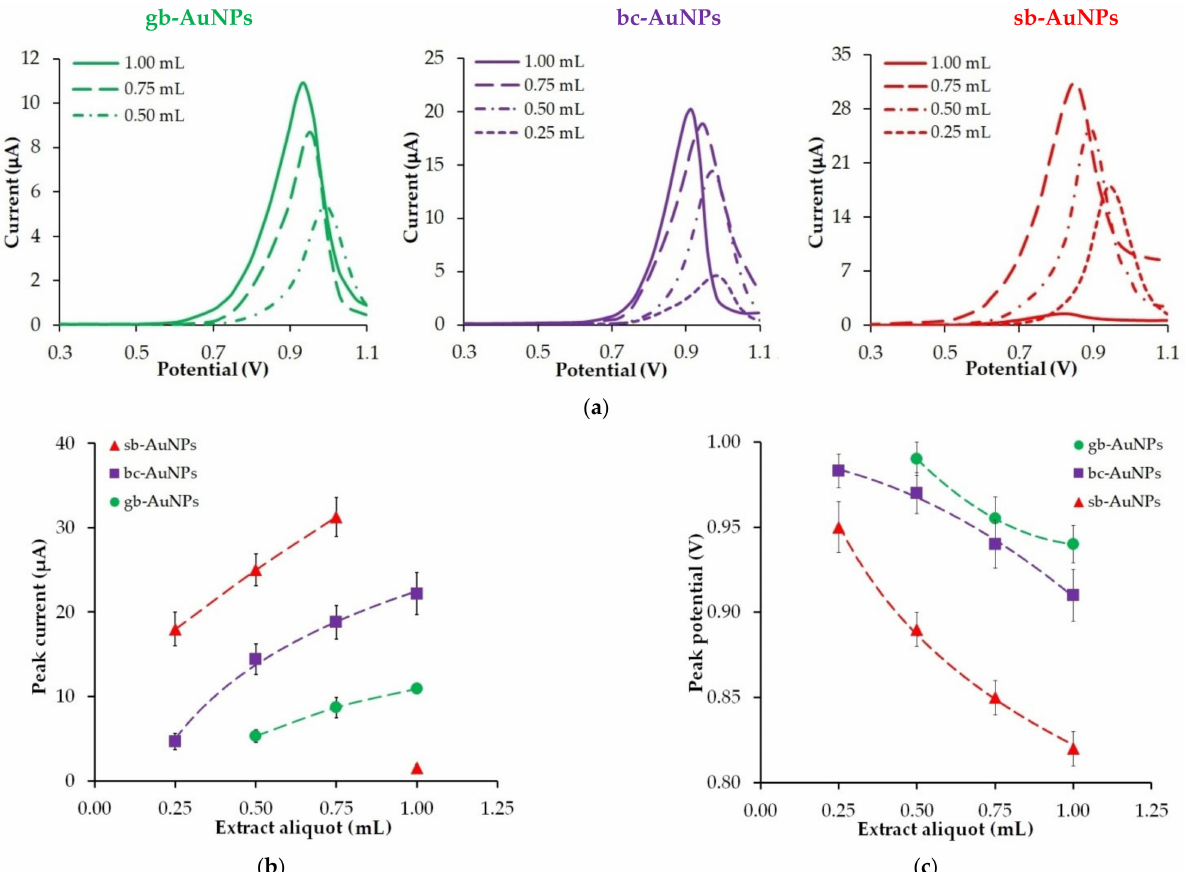
Figure 2. LS voltammograms of phyto-AuNPs electrooxidation ( a ). Background: 1 M HCl, potential scan rate 0.05 Vs − 1 . The impact of extract aliquots (pH 6) used in phytosynthesis on the peak current ( b ) and the peak potential ( c ) of phyto-AuNPs electro-oxidation. Synthesis conditions of phyto-AuNPs: C(HAuCl 4 ) = 1 mM, V extr = 0.25 − 1.00 mL, and pH 6 all of